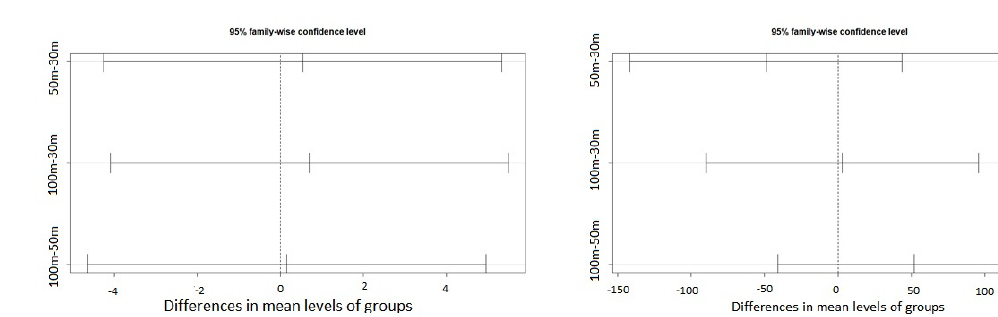
Figure 5. Post-hoc Tukey HSD test results of Conductivity (μS/cm) in the water column between riparian zone width